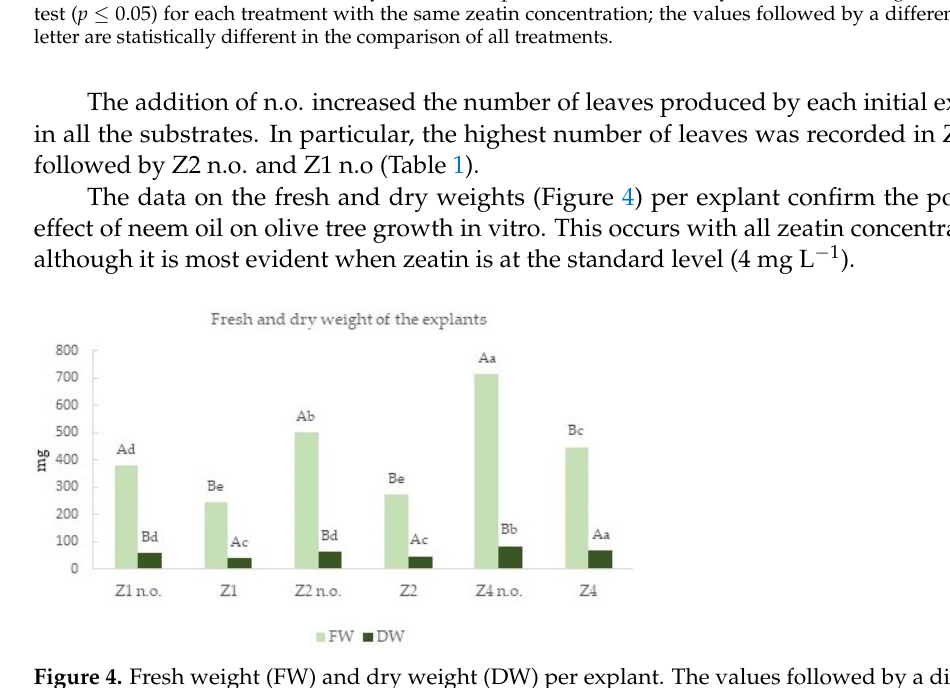
Figure 4. Fresh weight (FW) and dry weight (DW) per explant. The values followed by a different capital letter are statistically different according to Duncan’s test ( p ≤ 0.05) for each treatment with the same zeatin concentration; the values followed by a different small letter are statistically different in the comparison of all treatments. Therefore, the addition of neem oil induced the development of adventitious shoots, a greater: shoots’ length, leaves number, and plant fresh and dry weights.